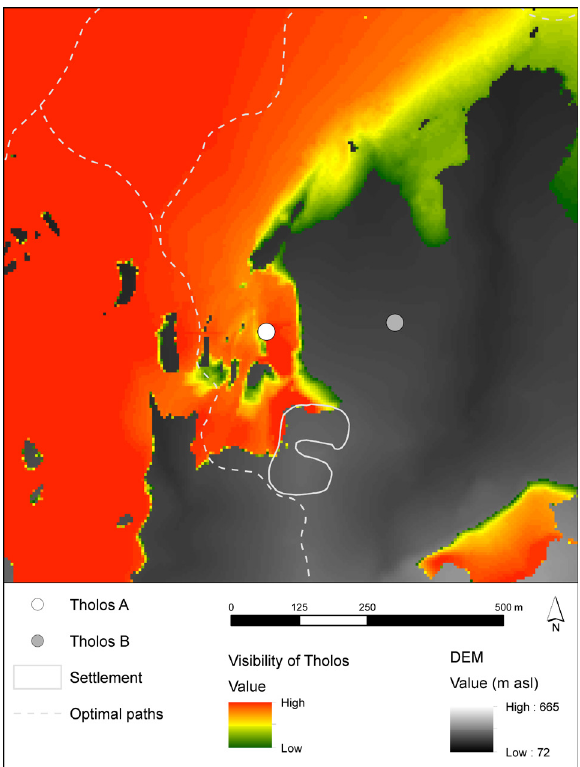
Figure 13. Optimal paths at Apesokari in relation to the viewshed of Tholos A – assuming a height of 4.4 m for Tholos